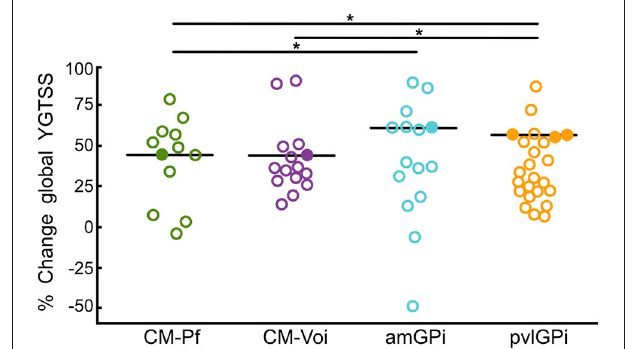
FIGURE 3 | Scatterplots of global YGTSS scores for all targets combined at different postoperative time points (T0: baseline; T1: ≤ 6 months; T2: ≤ 12 months; T3: > 12 months). Circles represent individual studies; color-filled circles represent more heavily weighted studies (more participants). Horizontal bars show the median values for each target. Significant differences between time points are indicated with asterisks ( p < 0.05).